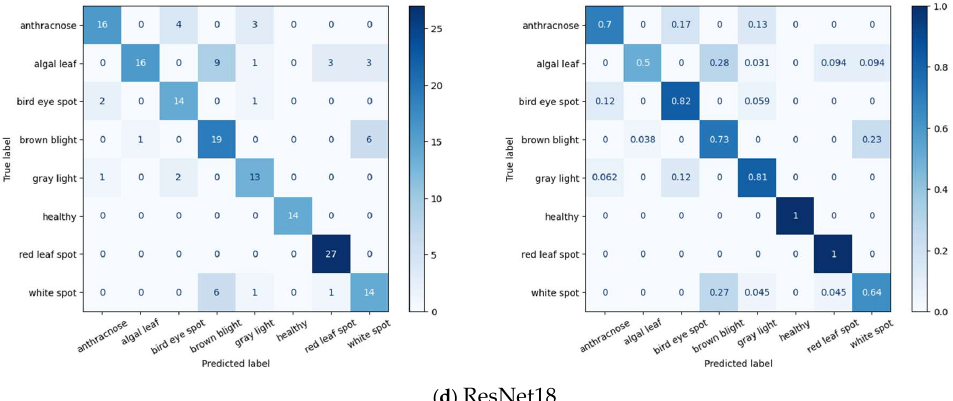
Figure 9. Tea disease recognition confusion matrix.